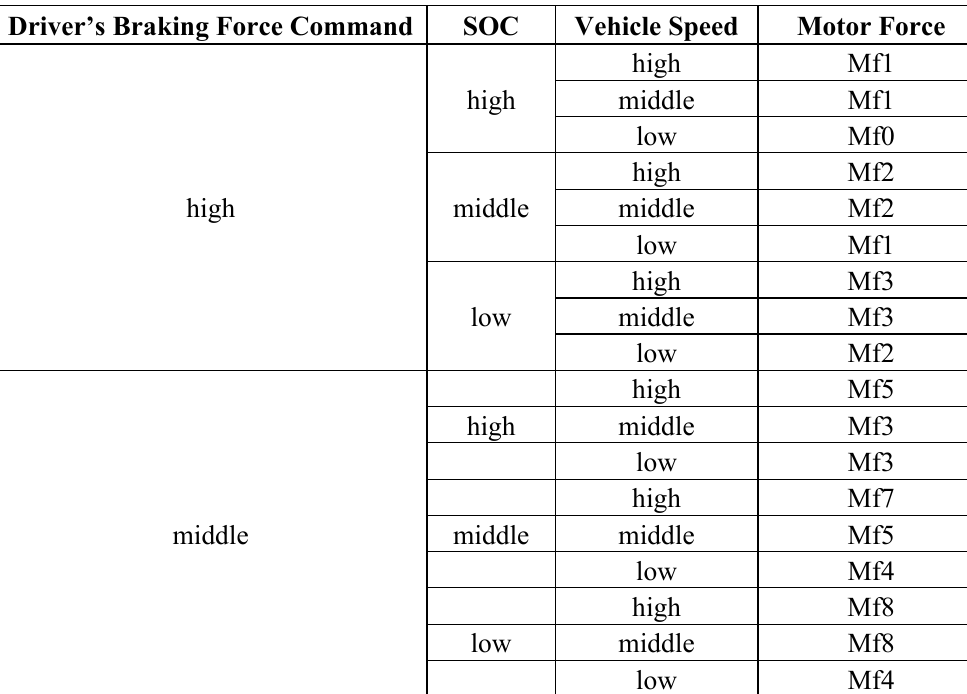
Table 3. Fuzzy rules